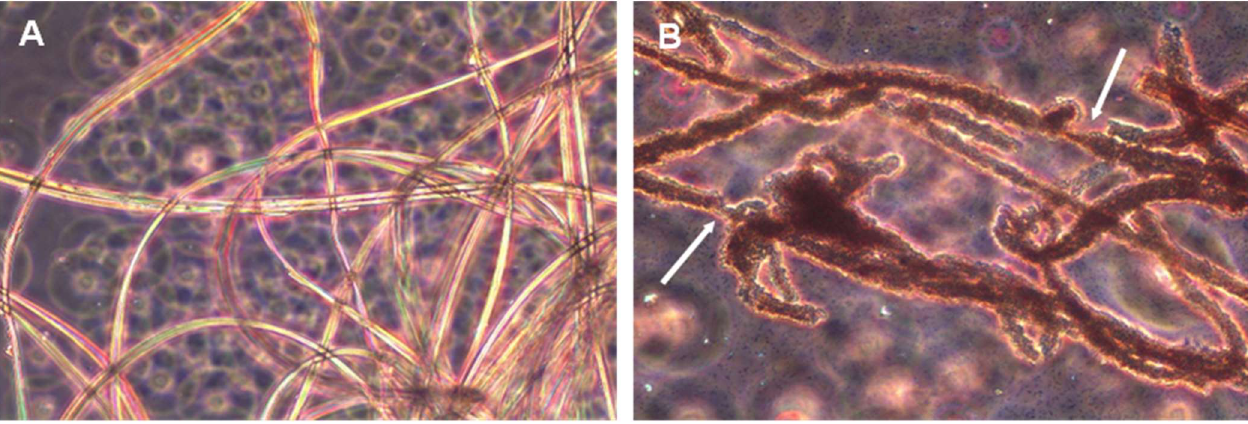
Figure 2. Observation of a P. aeruginosa pure culture under optical microscope (40 × ) in the presence of raw silk. ( A ) 12 h of incubation; ( B ) 48 h of incubation. Note the intense bacterial colonization observed on the surface of silk fibers in the 48-hour culture, where silk biodegradation was already apparent. At some points fibers experienced a considerable decrease in thickness (points marked with arrows), which could cause the fibers to break into shorter fragments.